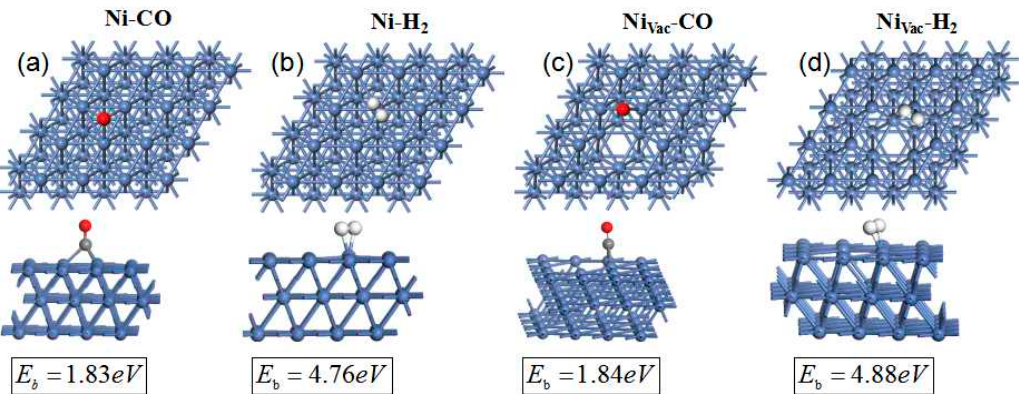
Figure 8. First-principles study of surface CO and H 2 adsorption on different sites. Top and side views of the structures of ( a ) Ni and ( c ) Ni vacancies with CO adsorption, ( b ) Ni, ( d ) Ni vacancies with H 2 adsorption. DFT-calculated adsorption energies (E b ) of CO and H 2 molecules on the surfaces of Ni and Ni vacancies are also presented, respectively. Blue, red, gray and white balls represent the Ni, O, C, and H atoms, respectively.